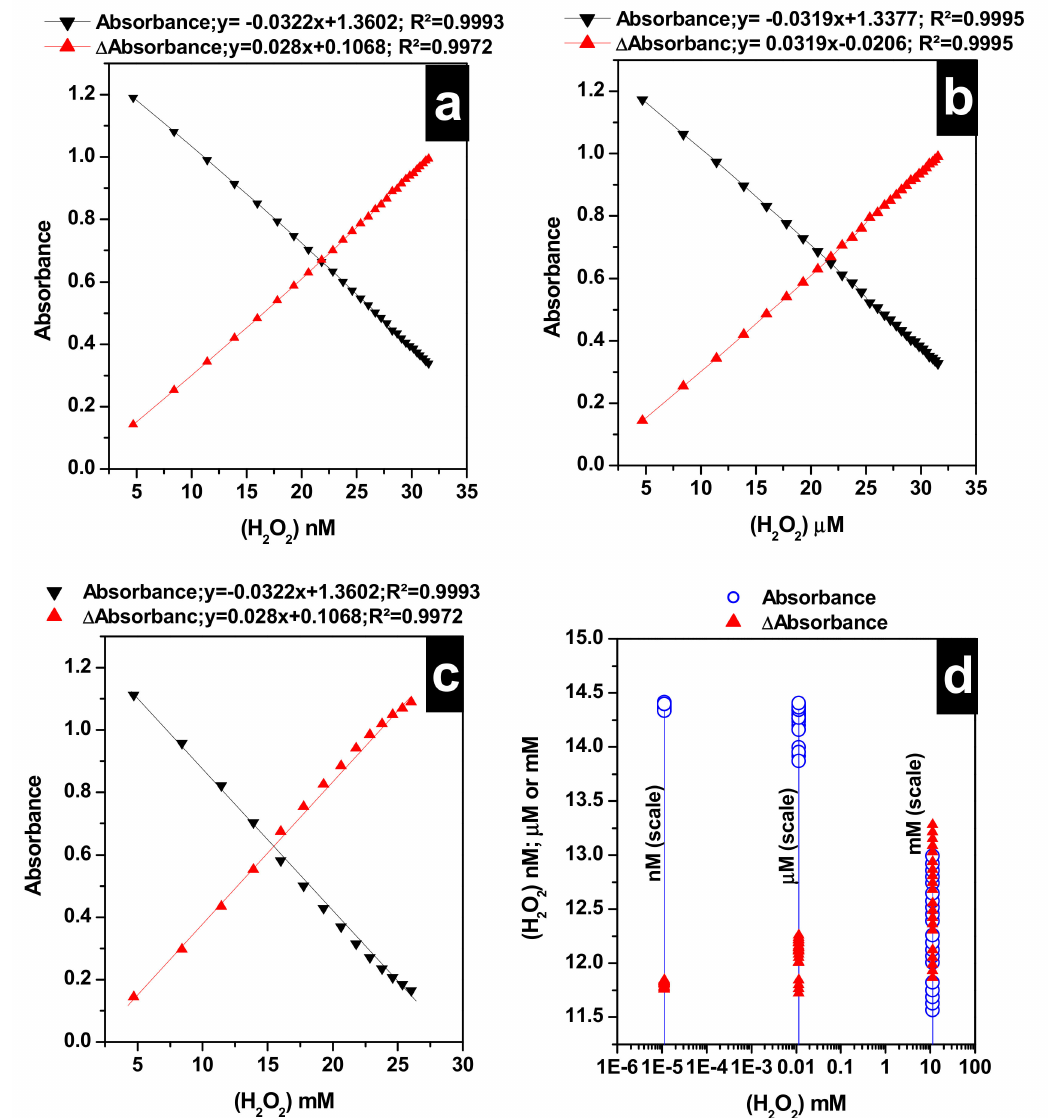
Figure 5. Calibration curves of H 2 O 2 detection using LSPR absorbances of the Algae-AgNPs and LSPR ∆ Abs between the reference and the sample at 25 ◦ C ( a ) 4.7 to 32 nM range; ( b ) 4.7 to 32 µ M range; ( c ) 4.7 to 32 mM range; ( d ) determination of unknown concentrations from di ff erent ranges, V unknown (H 2 O 2 ) = 0.3 mL; V (Algae-AgNPs) = 0.75 mL; pHi (Algae-AgNPs) =